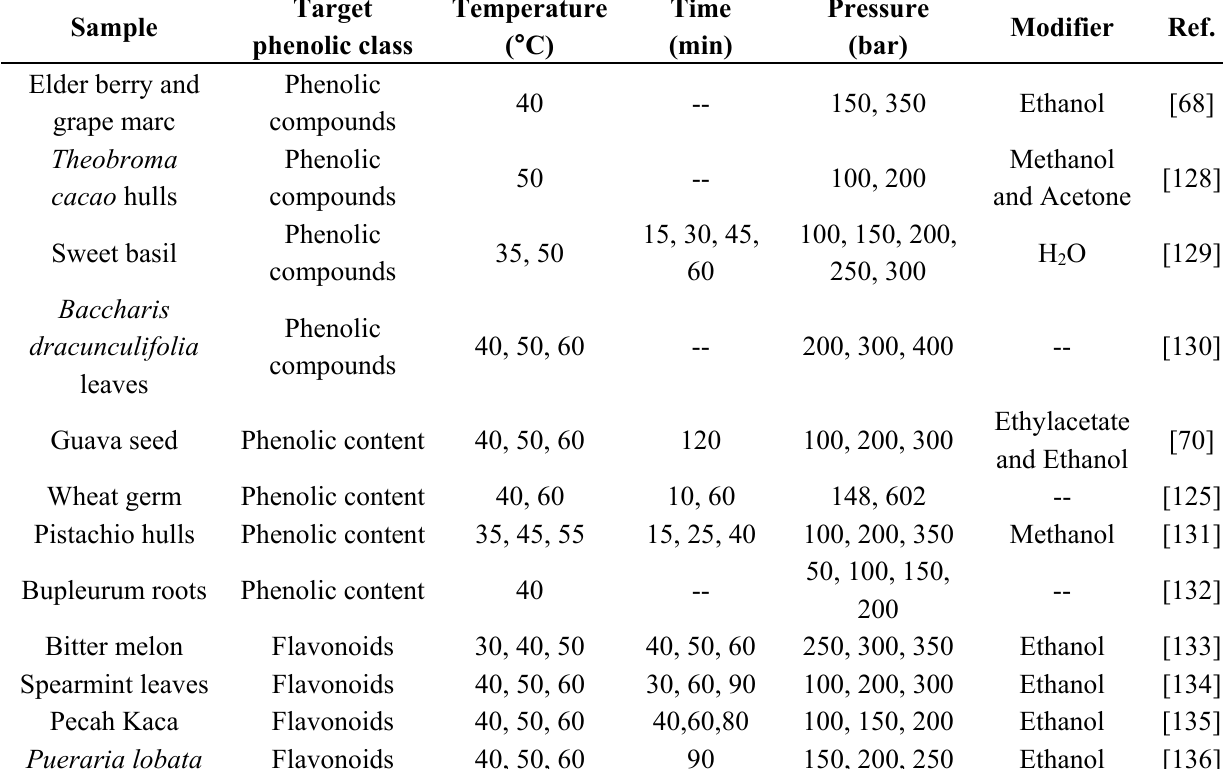
Table 6. SFE conditions for extraction of phenolic compounds from plant-based samples.